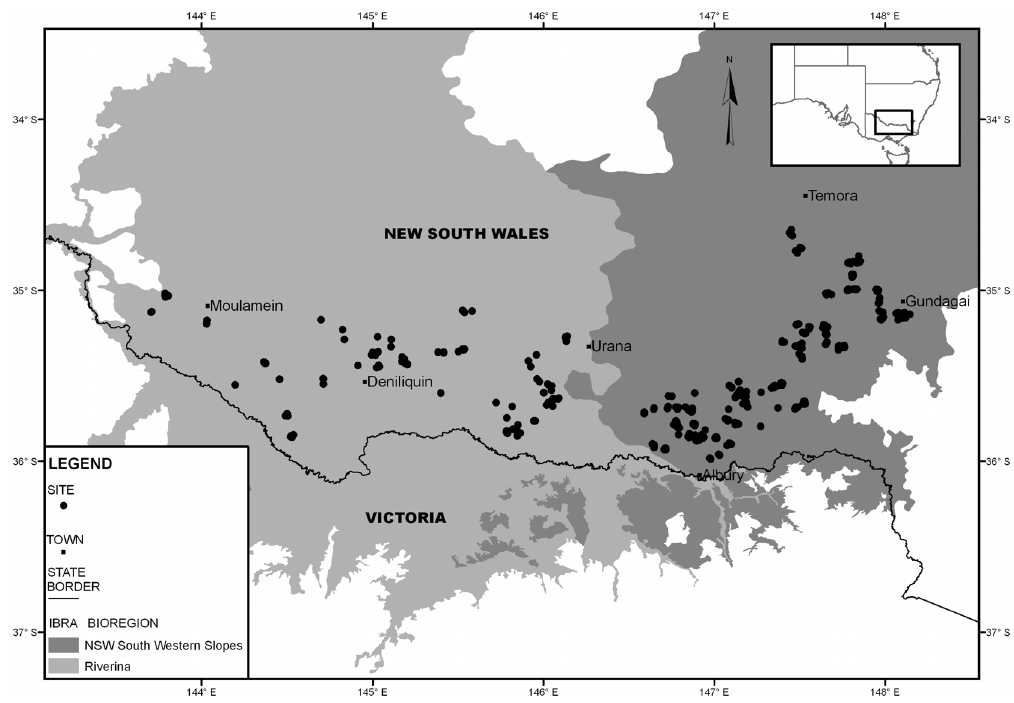
Figure 1. The Riverina and South-west Slopes study region in southern New South Wales, south-eastern Australia.